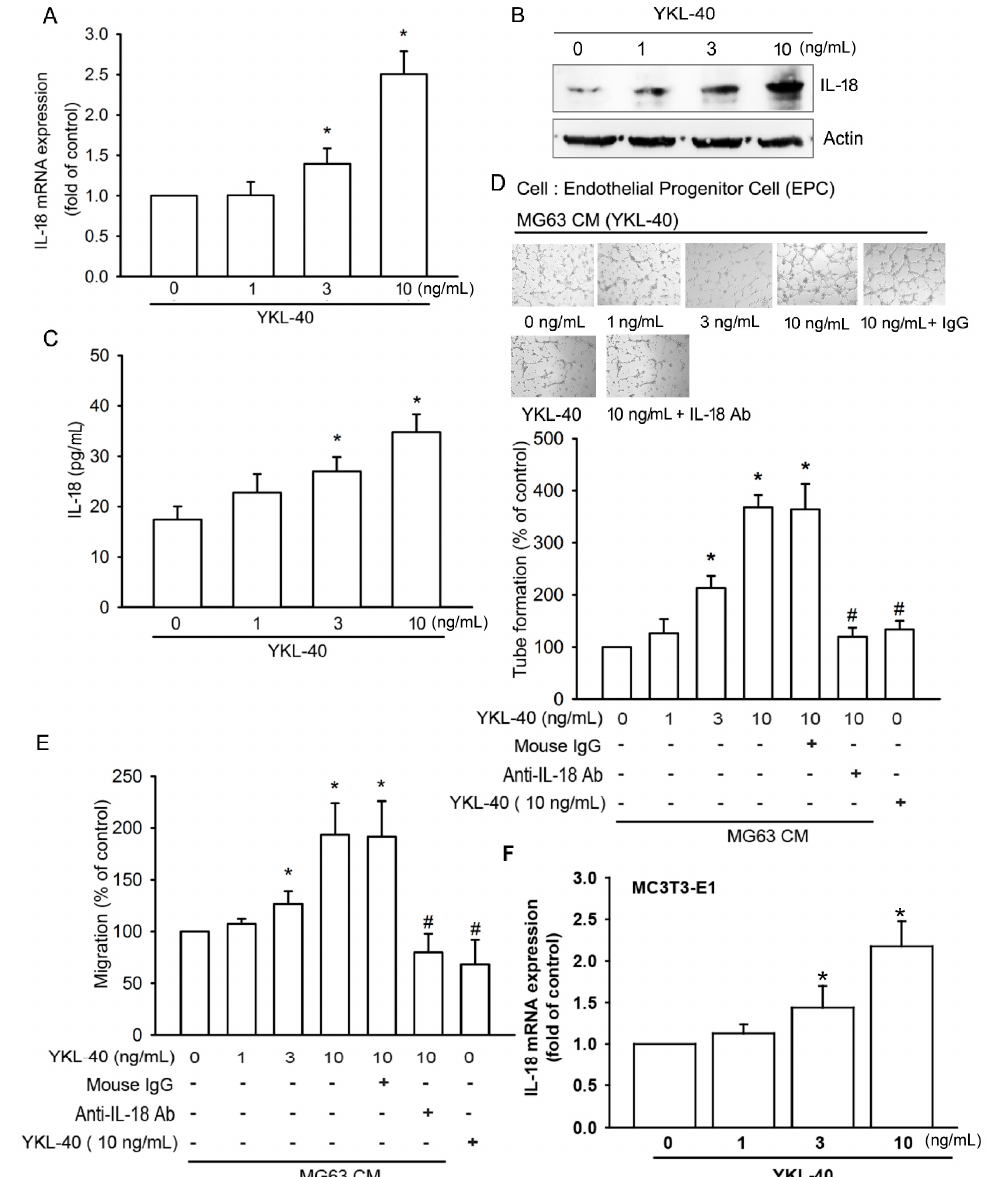
Figure 1. YKL-40 increases IL-18 expression in osteoblasts and promotes endothelial progenitor cell (EPC) angiogenesis. ( A – C ) MG-63 cells were treated with prespecified concentrations of YKL-40 (0–10 ng/mL) for 24 h. IL-18 expression was examined by qPCR, Western blotting, and ELISA ( n = 4 per group). ( D , E ) MG-63 cells were treated with YKL-40 (0–10 ng/mL), or pretreated for 30 min with control IgG or IL-18 antibody for 30 min then stimulated with YKL-40 (10 ng/mL) for 24 h. Medium was collected as collected medium (CM). Two hundred microliters of 20% FBS MV2 medium and 150 µ L of osteoblast CM was then applied to EPCs. Capillary-like structure formation and in vitro cell migration in EPCs was examined by tube formation and Transwell assay. Direct application of YKL-40 had no effect upon EPC tube formation and migration ( n = 5 per group). ( F ) MC3T3-E1 cells were treated with prespecified concentrations of YKL-40 (0–10 ng/mL) for 24 h. IL-18 mRNA expression was examined by qPCR ( n = 3 per group). Results are expressed as the mean ± S.E. * p < 0.05 compared with control. # p < 0.05 compared with the YKL-40-treated group.